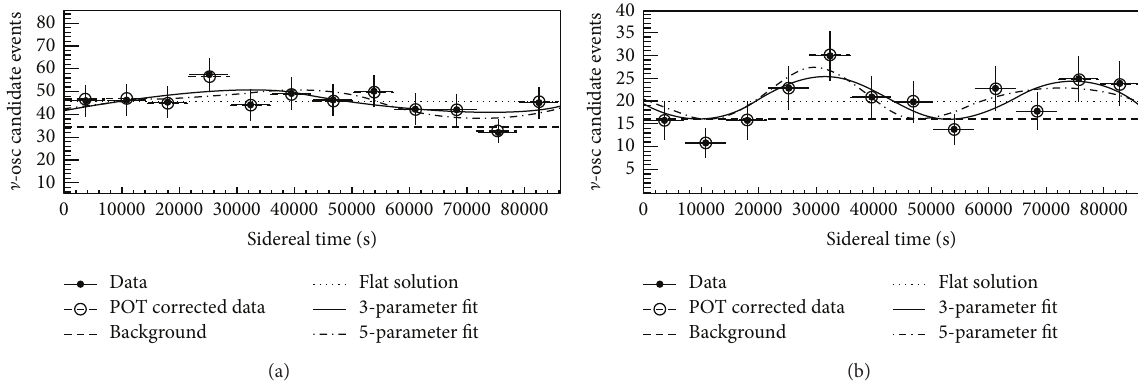
Figure 12: The MiniBooNE Lorentz violation results [103]. (a) shows the neutrino mode electron-like low energy excess sidereal time distribution, and (b) shows the antineutrino mode sidereal time distribution. Here, the data with a POT correction (open circle) show the size of the beam day-night variation. There are three fit curves based on different assumptions, a flat solution (dotted), a three-parameter fit (solid curve), and a full five-parameter fit (dash-dotted curve).